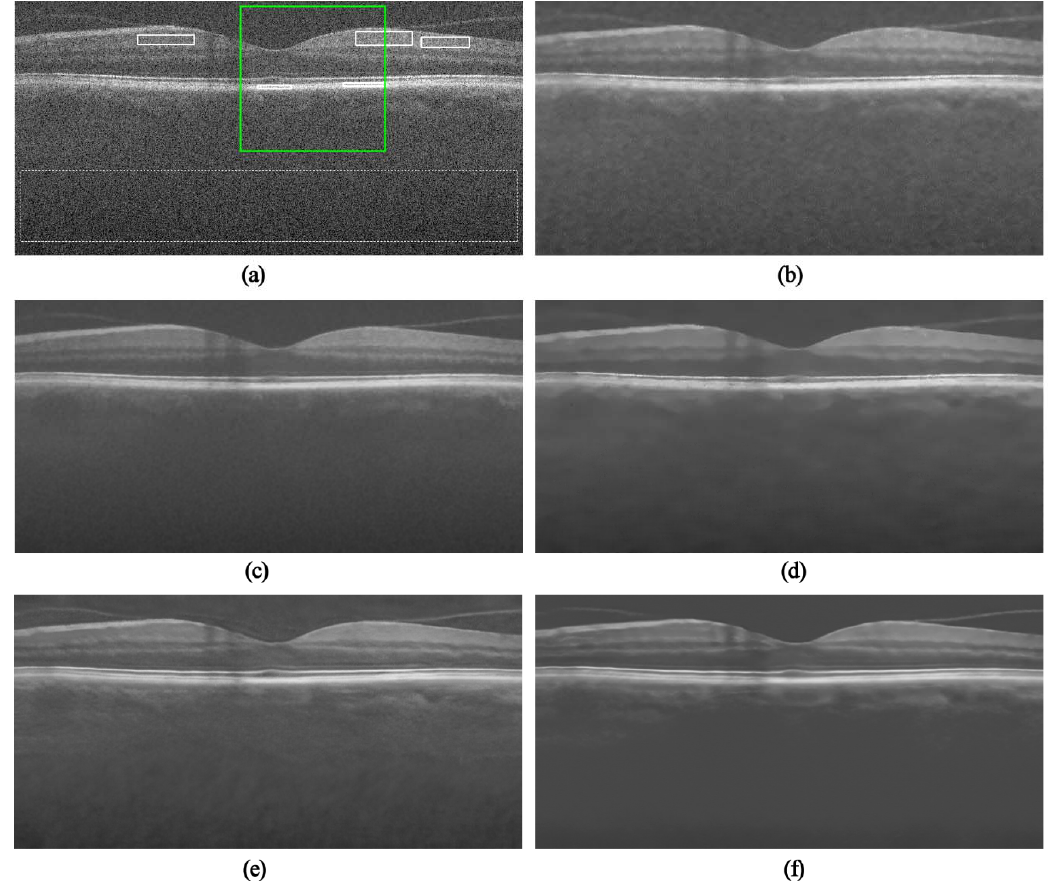
Figure 4. Comparison of denoising OCT-15 image in the synthetic dataset: ( a ) original noisy image (900 × 450), ( b ) image after TNode speckle reduction, ( c ) image after SBSDI speckle reduction, ( d ) image after PNLM speckle reduction, ( e ) image after DIP speckle reduction, ( f ) image after NLM-DIP speckle